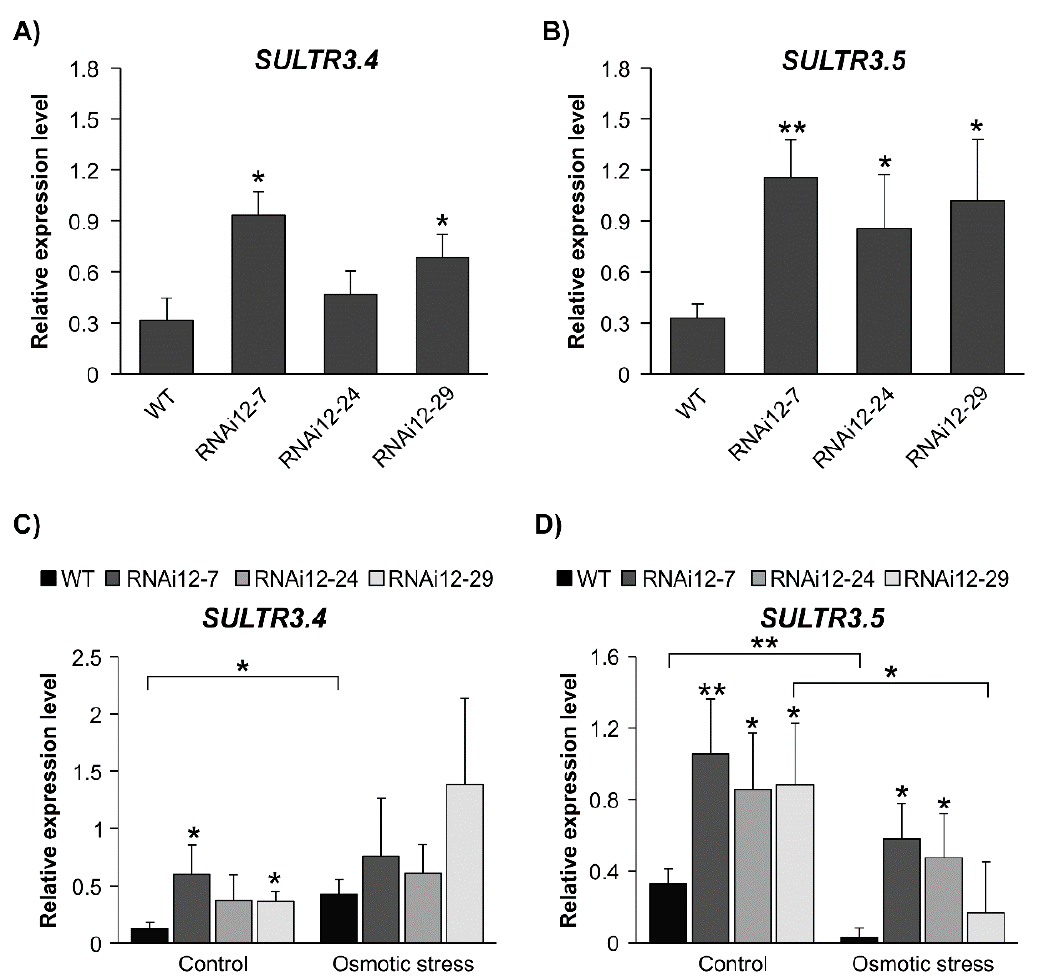
Figure 8. Effect of osmotic stress on transcript levels of sulphate transporter genes in WT and SPL12 -RNAi alfalfa plants. Relative transcript levels of ( A ) SULTR3.4 and ( B ) SULTR3.5 in WT and SPL12- RNAi plants. Relative transcript levels of ( C ) SULTR3.4 and ( D ) SULTR3.5 in WT and SPL12 -RNAi alfalfa exposed to three weeks of osmotic stress (400 mM mannitol). * and ** indicate significant differences relative to WT using Student’s t -test (n = 3) p < 0.05, p < 0.01, respectively. Error bar indicates standard deviation.